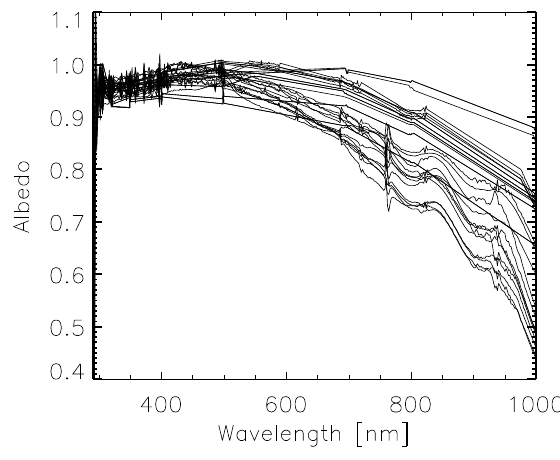
Fig. 10. All of these albedo spectra are measured at Neumayer with solar zenith angles between 48 ◦ and 49 ◦ on different days and times (morning and/or afternoon). The difference in albedo spectra is low- est at 400nm with 0.08 and it becomes larger the larger the wave- length.